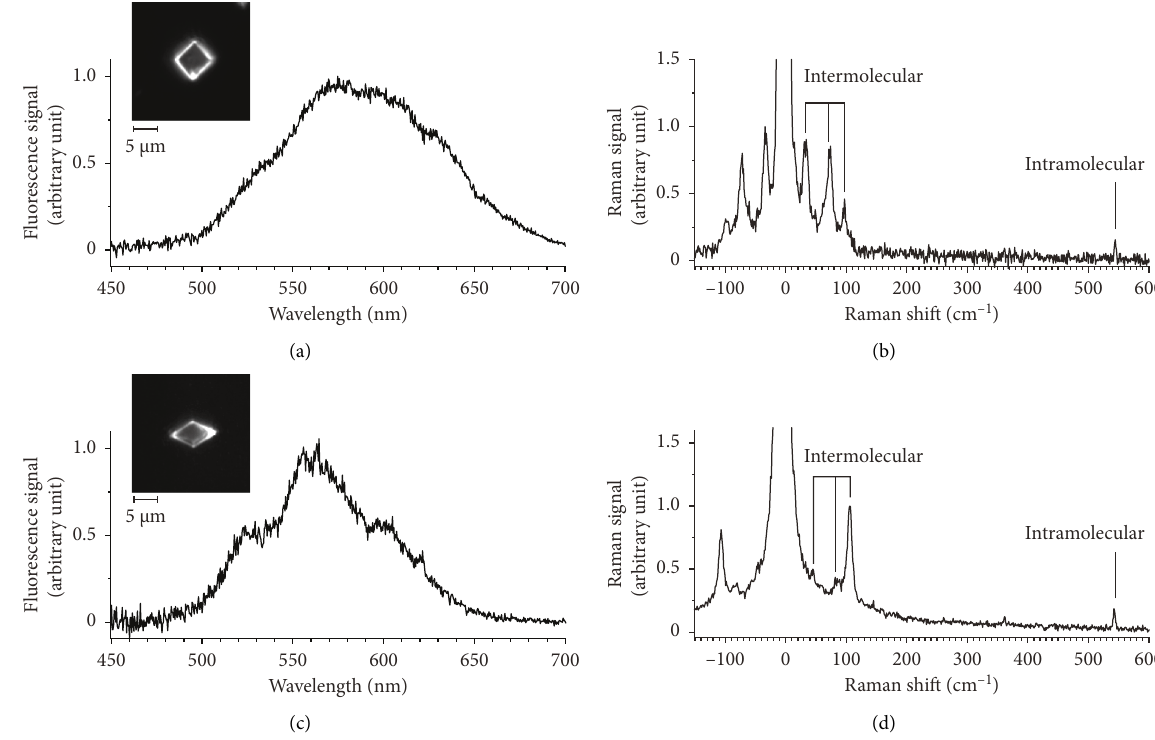
Figure 5: Fluorescence images, fluorescence spectra, and ultralow-frequency Raman spectra of the individual perylene microcrystals. (a) Fluorescence spectrum of a microcrystal with a square shape. Inset: fluorescence image of the crystal. (b) Ultralow-frequency Raman spectrum of the crystal shown in the inset of (b). Three intermolecular vibration modes in the ultralow-frequency region and one intramolecular vibration mode are observed. (c) Fluorescence spectrum of a microcrystal with a rhombic shape. Inset: fluorescence image of the crystal. (d) Ultralow-frequency Raman spectrum of the crystal shown in the inset of (c). Three intermolecular and one intramolecular vibration modes are